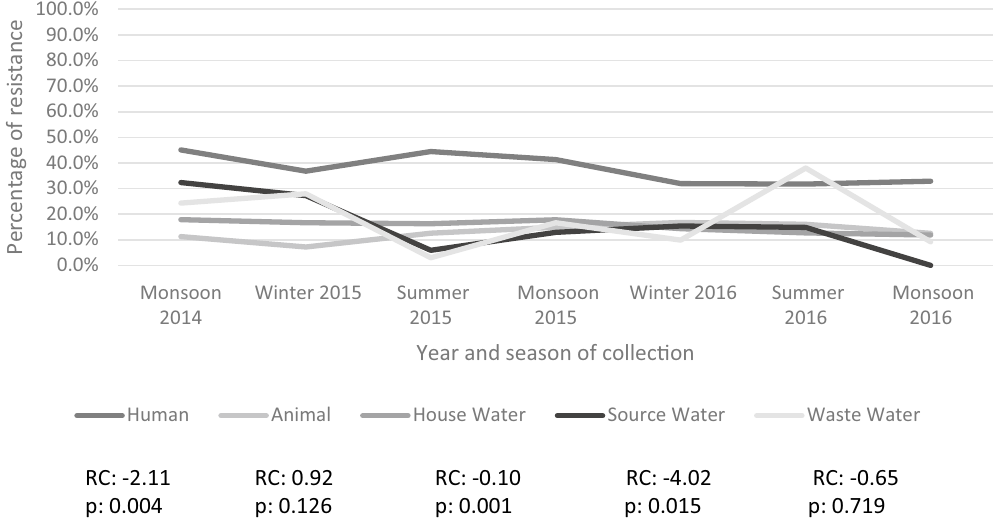
Figure 4. Line graph of over time trend of percentage of production of ESBL, with regression coefficients and p -value for Newey–West analyses. RC Regression Coefficient p = p